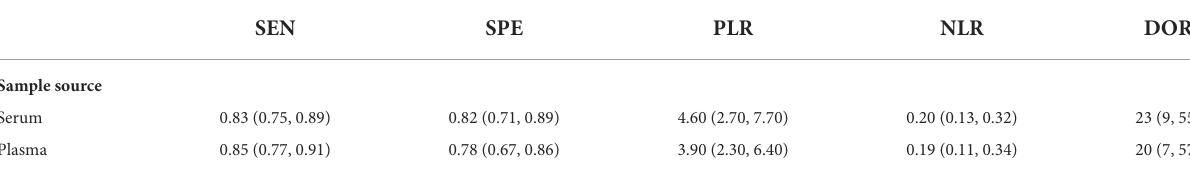
TABLE 2 Subgroup